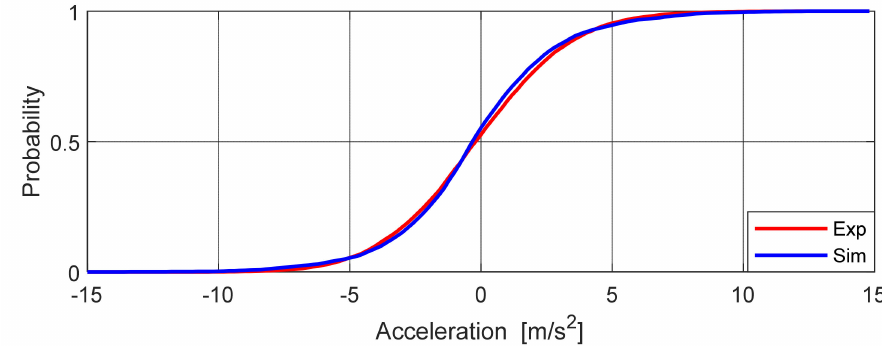
Figure 34. Distribution function, acceleration on vehicle FA.